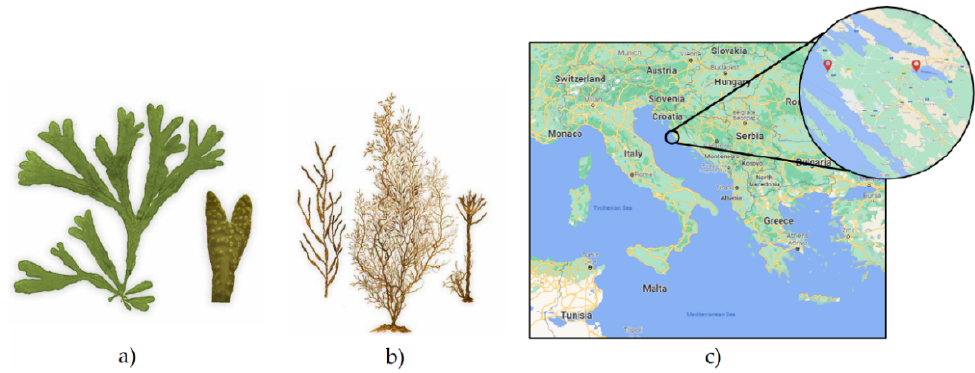
Figure 1. ( a ) Fucus virsoides; ( b ) Cystoseira barbata ( c ); location of seaweed collection .